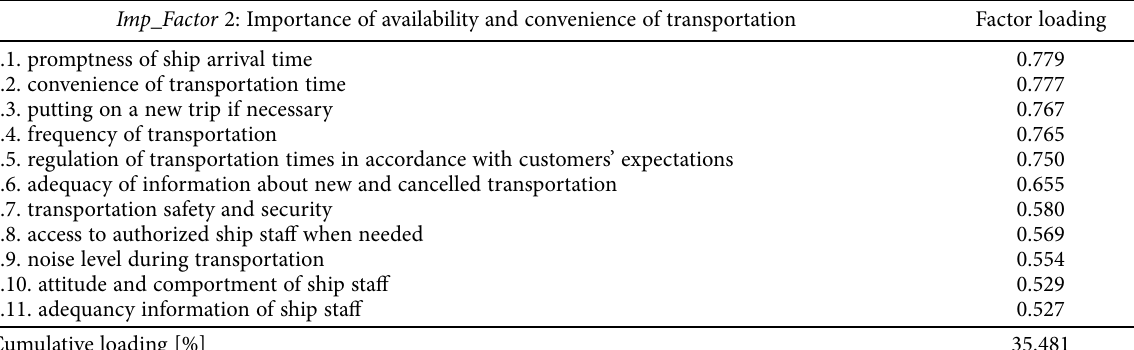
Table 12. Importance Factor 2 factor